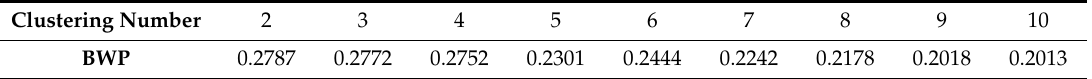
Table 2. BWP index of Z 1 with di ff erent number of clusters.